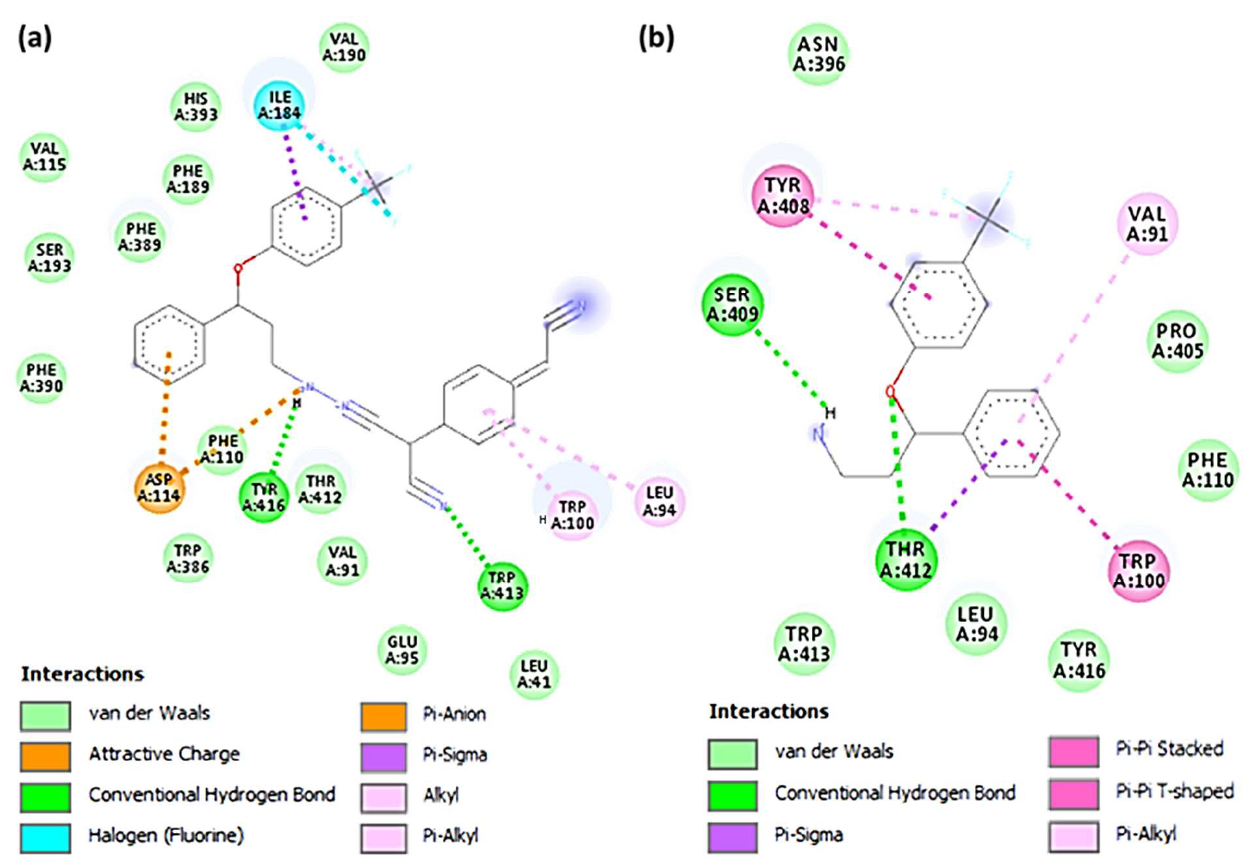
Figure 9. Two-dimensional representation of interactions of dopamine docked with ( a ) CT complex and ( b )